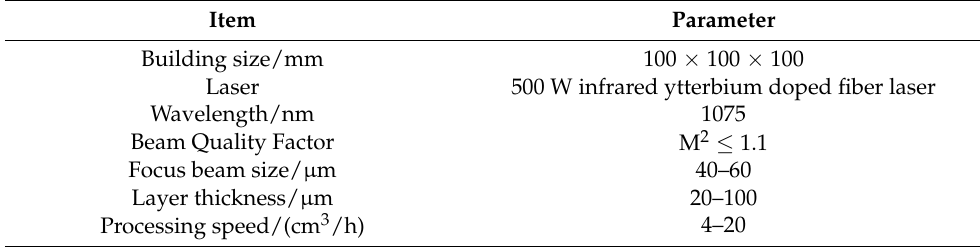
Table 1. Main equipment parameters of SLM Dimetal-100H device.